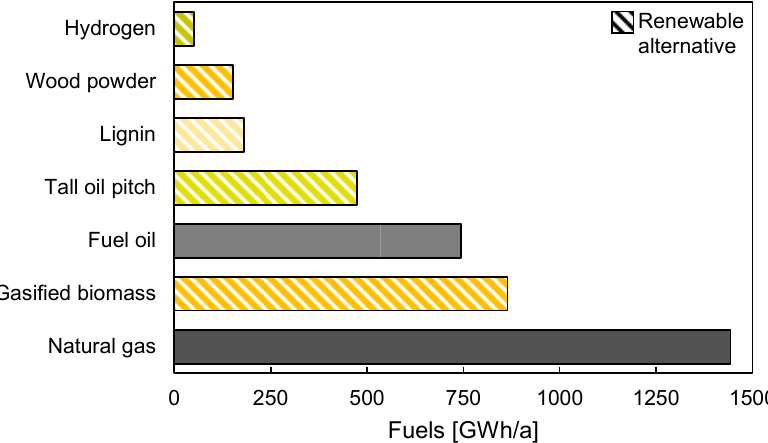
Figure 4. Estimated current fuel mix in lime kilns of the Finnish pulp and paper industry.